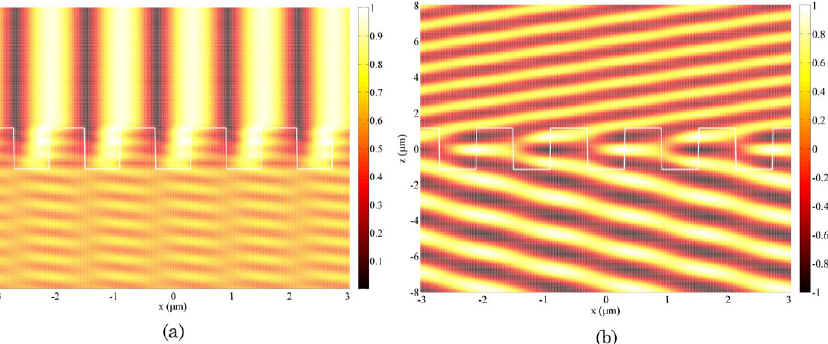
Figure 27. Near ‐ field distribution for a dual ‐ function grating with a period of 1216 nm and a depth Figure 27. Near-field distribution for a dual-function grating with a period of 1216 nm and a depth of